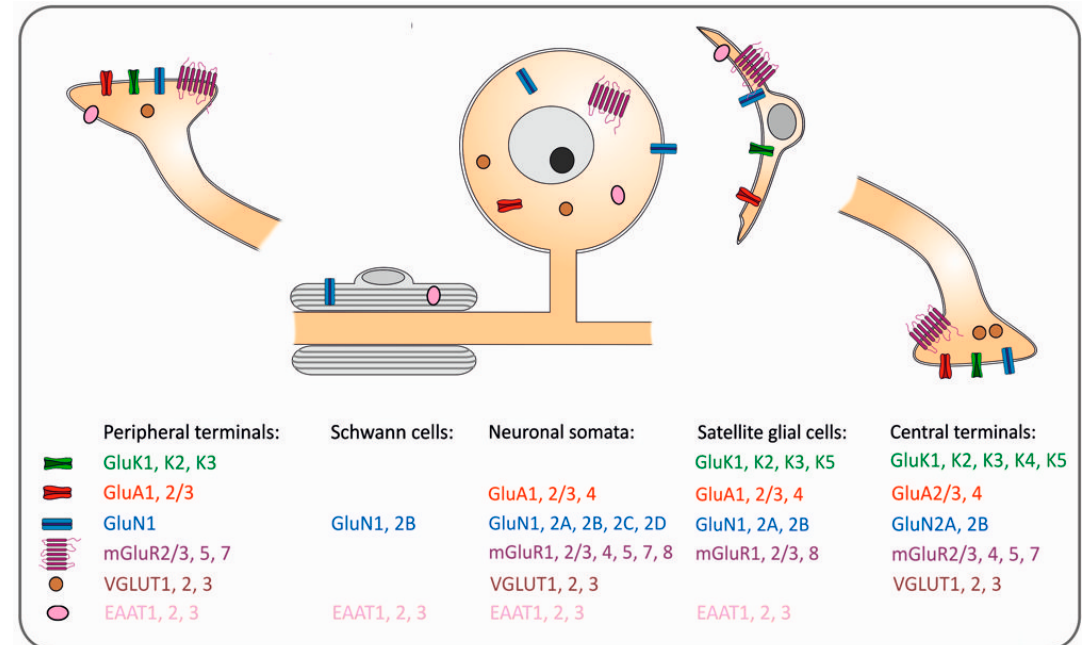
Figure 3. Summary sketch showing the presence of glutamate-related receptors and transporters in the main cell types within the sensory ganglia and the peripheral and central neuronal branches of primary sensory neurons.